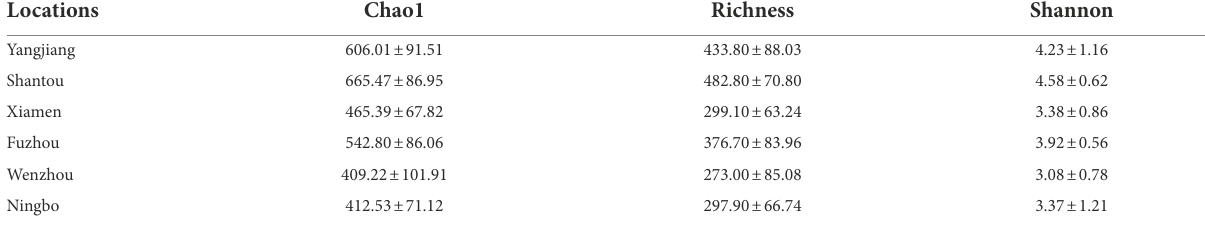
TABLE 1 Alpha-diversity of gut microbiota in Fejervarya limnocharis along the eastern coast of mainland China.